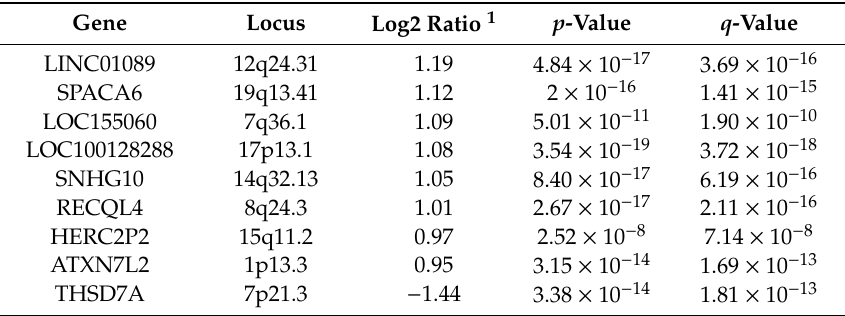
Table 2. Composition of SigIQGAP1NW.